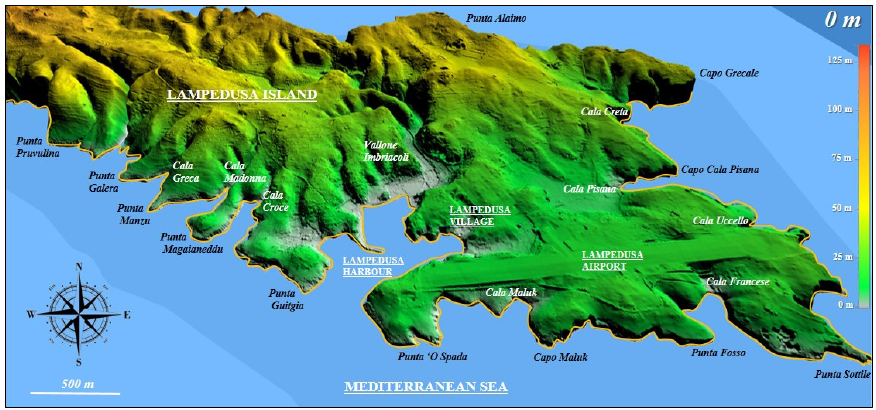
Figure 7. Actual geomorphological setting of the south ‐ eastern area of Lampedusa island.